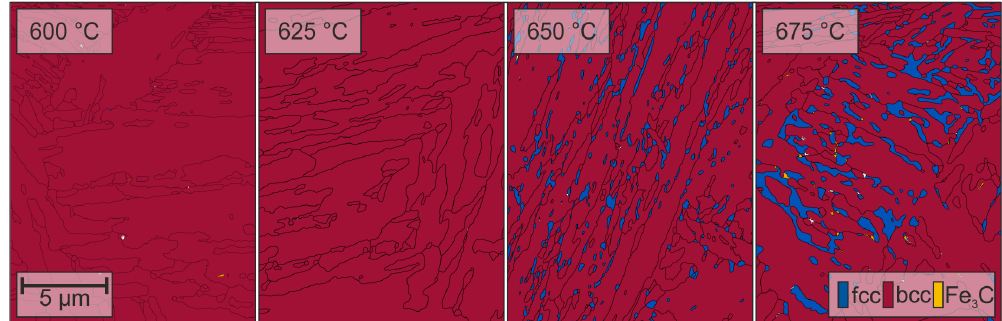
Figure 7. Electron backscatter diffraction (EBSD) phasemaps of austenite distribution after annealing for 1h with different annealing temperatures. As the austenite is not homogenously distributed in the matrix the volume fraction can just be estimated. For 600 ◦ C and 625 ◦ C less than 1 vol.% was detected. For 650 ◦ C the approximated volume fraction is around 10 vol.% and for 675 ◦ C 20 vol.% have been